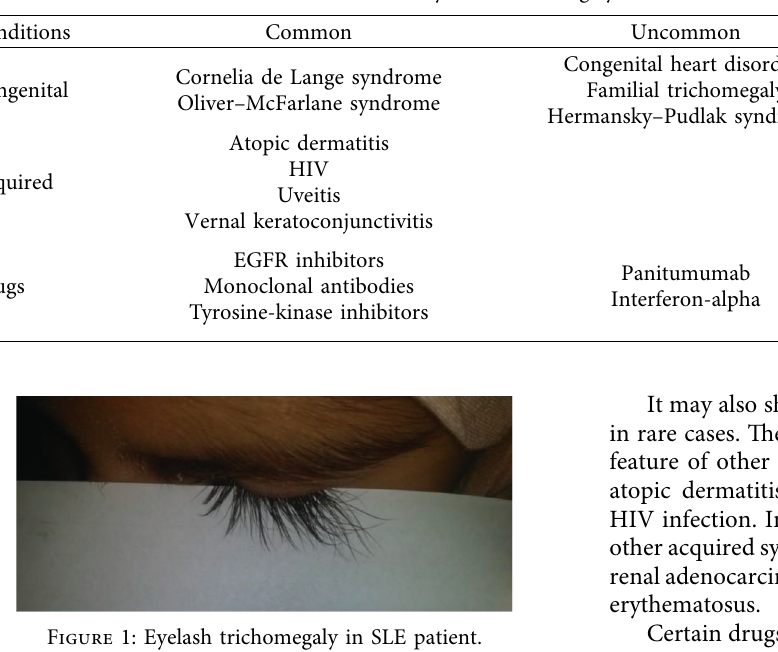
Table 1: Eyelash trichomegaly: causes and occurrence.